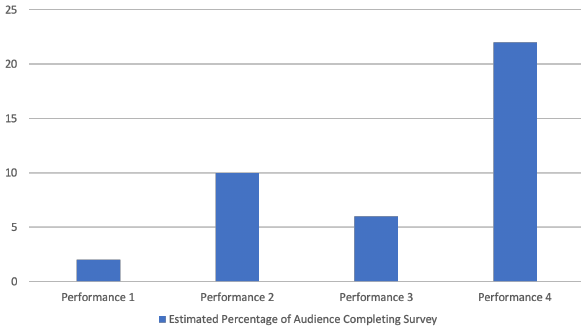
Figure 5: The estimated percentage of the audience at each perfor- mance that completed a survey, showing an overall increase, espe- cially by Performance 4. Adjustments to the survey structure and number of audience members varied per evening, causing changes in the number of completed surveys across the